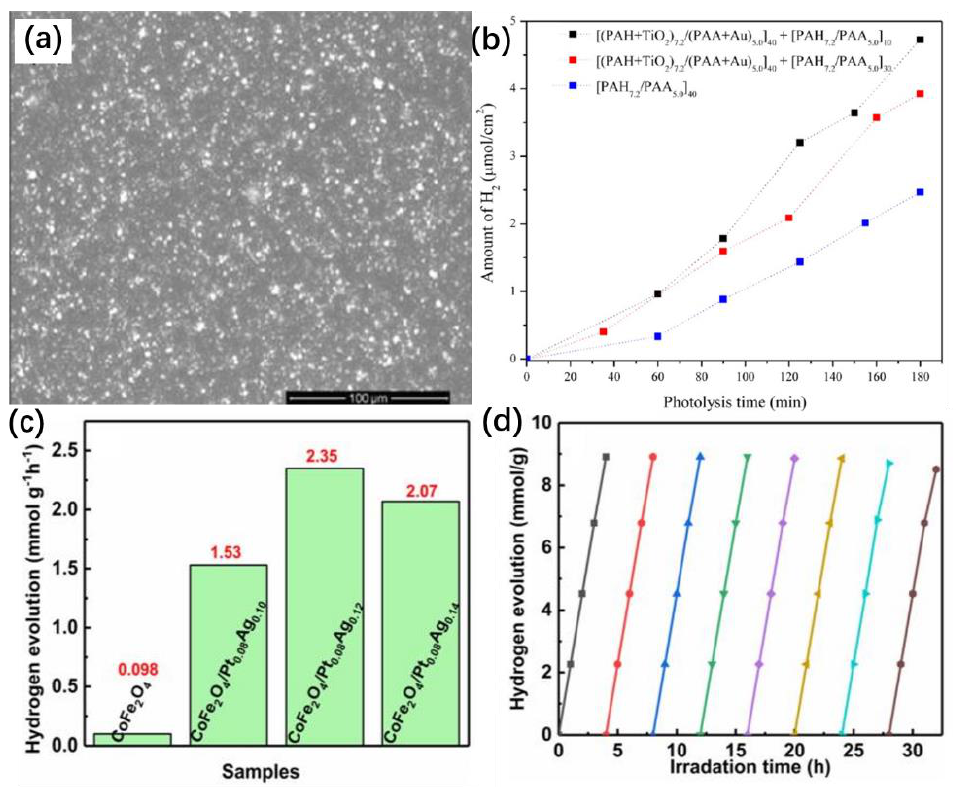
Figure 7. ( a ) SEM images of self-assembled photocatalytic films (SAPF) with 60 layers on a silicon substrate. ( b ) Hydrogen evolution in aqueous solution of methanol when films were irradiated with a 300-W Xe/Hg lamp. Copyright © 2013 American Chemical Society. ( c ) Average photocatalytic hy- drogen evolution rates of CoFe 2 O 4 , CoFe 2 O 4 /Pt 0.08 Ag 0.10 , CoFe 2 O 4 /Pt 0.08 Ag 0.12 , and CoFe 2 O 4 /Pt 0.08 Ag